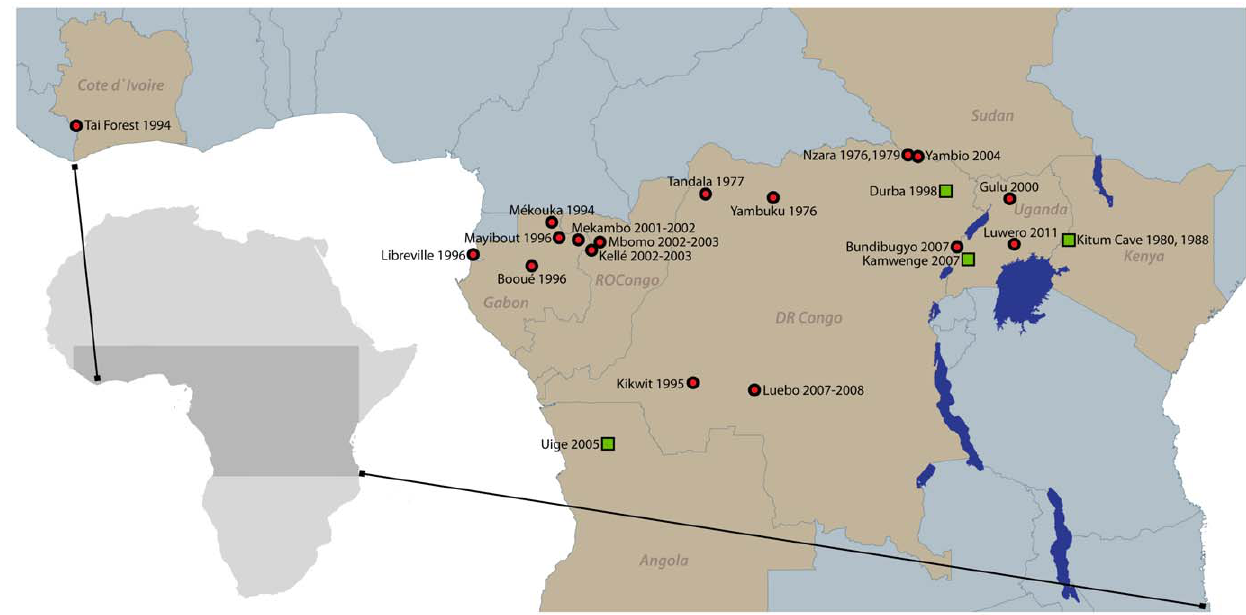
Figure 1. Location of Ebola hemorrhagic fever (red circles) and Marburg hemorrhagic fever (green squares) outbreaks.